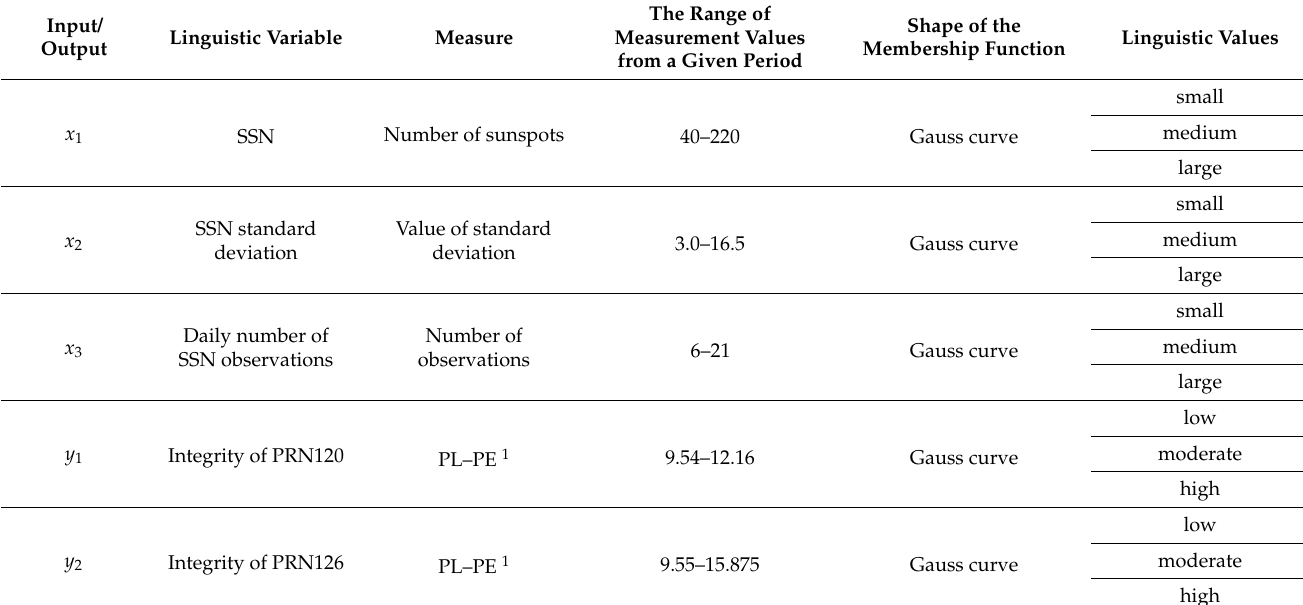
Table 1. Definition of the fuzzy sets including membership